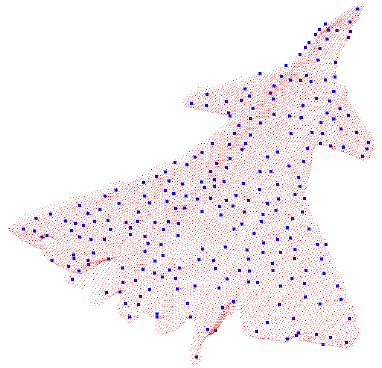
Figure 7. Model point cloud using the ISS key point extraction algorithm. High ‐ quality feature descriptors can improve the accuracy of feature matching, re ‐ duce mismatches, and improve the subsequent point cloud registration results. The con ‐ struction process of a feature histogram is generally divided into two parts: feature signa ‐ ture and histogram statistics. The feature signature is more descriptive, while the feature histogram is more robust. SHOT [23] combines the two. The feature point p of the point cloud is taken as the center of the circle, and a neighborhood with a radius of R is obtained.